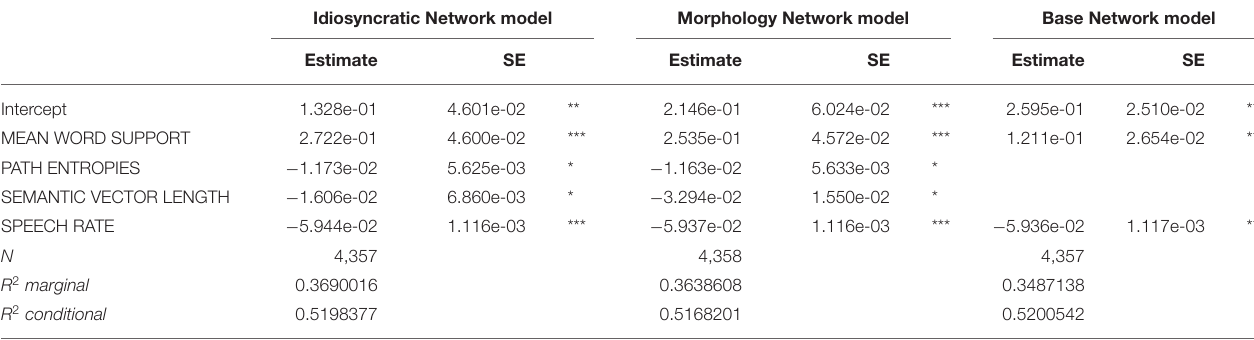
TABLE 4 | Final mixed-effects regression models reporting effects on duration difference with variables from the three